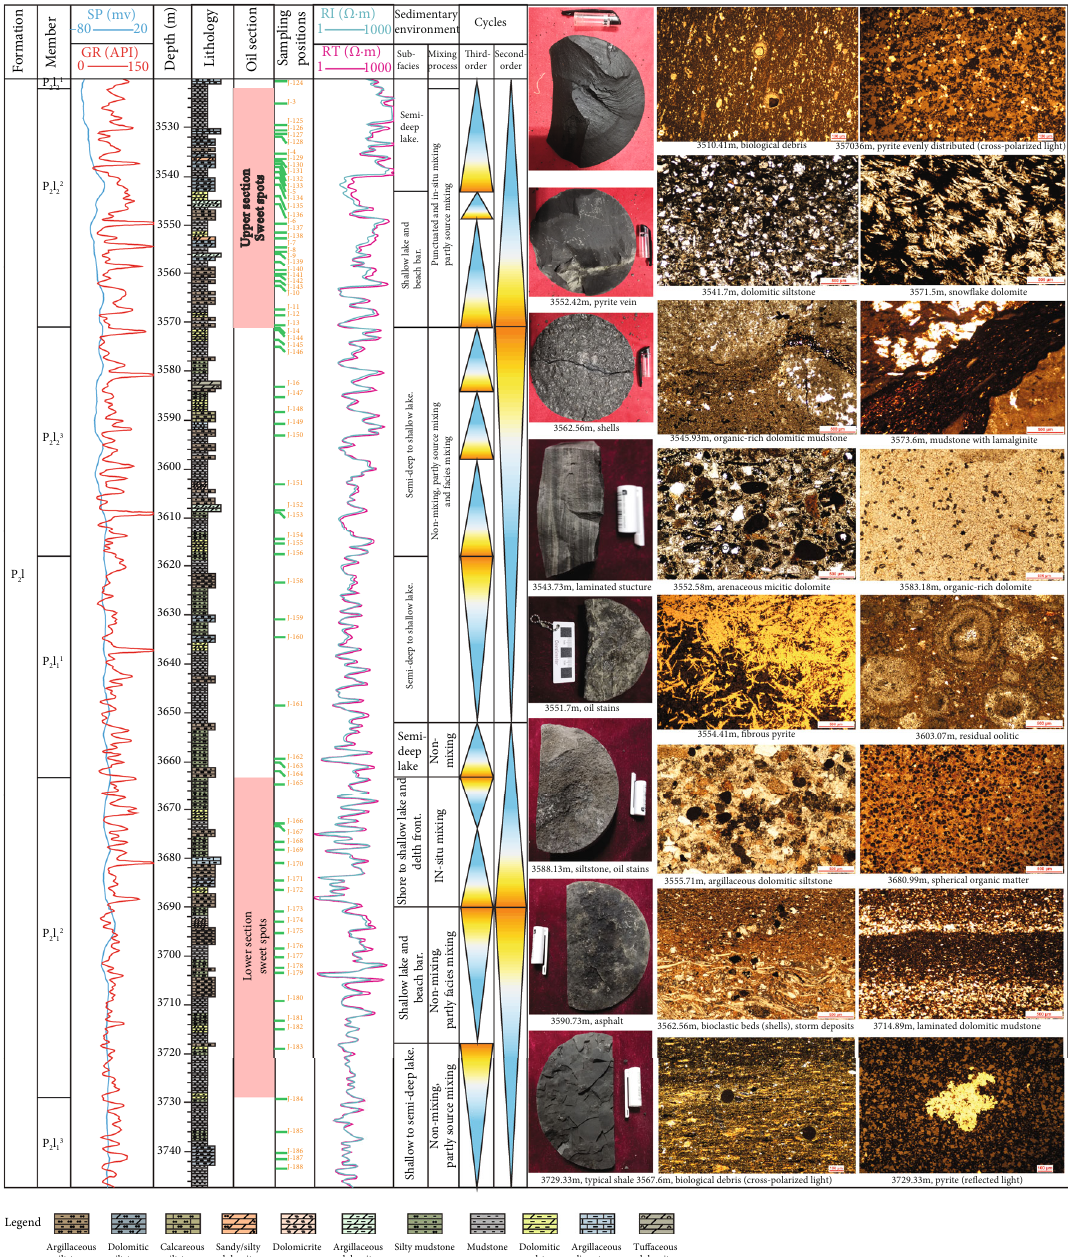
Figure 2: Composite columnar section of well J10025 in the Jimusar Sag. The location of the well is shown in Figure 1(b). The logging data and samples were collected by PetroChina Xinjiang Oil fi eld